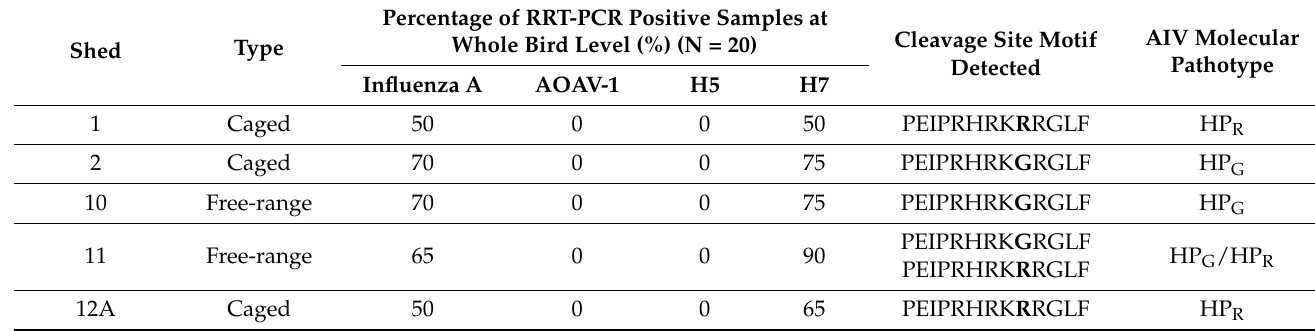
Table 2. Real-time reverse-transcription (RRT)-PCR and sequencing results from Sample Set 2. Hemagglutinin (HA) cleavage site (CS) motifs for each shed were determined based on sequencing of individual swabs and/or viral isolates. High pathogenicity (HP) G ; HA CS motif PEIPRHRK G RGLF, HP R ; HA CS motif PEIPRHRK R RGLF. Shed Type